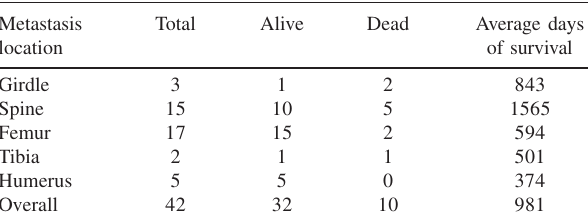
Table 3- Days of survival by location of the bone metastasis